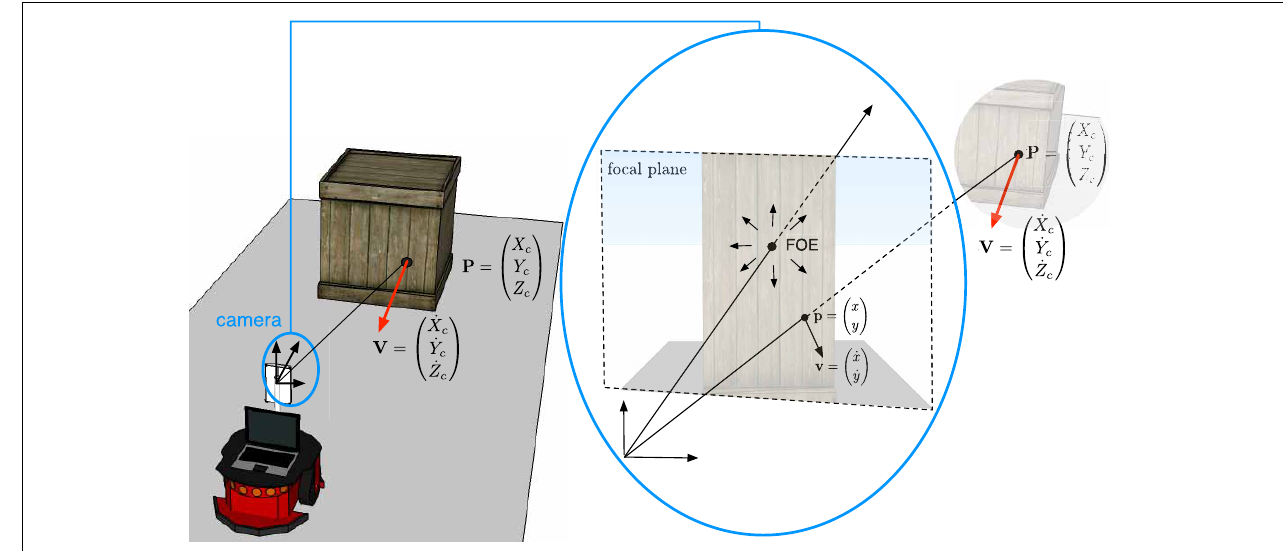
FIGURE 4 | 3D obstacle velocity V projected into the camera focal plane as v . The dotted letters refer to temporal derivatives of each component.